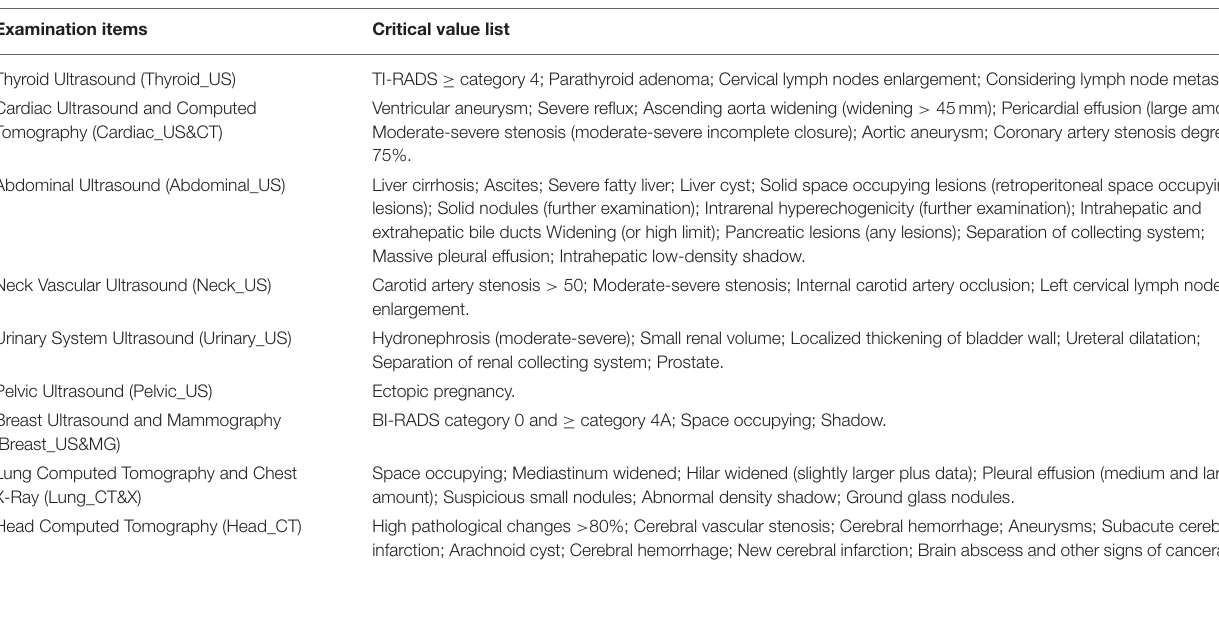
TABLE 2 | The critical value list in health checkup for